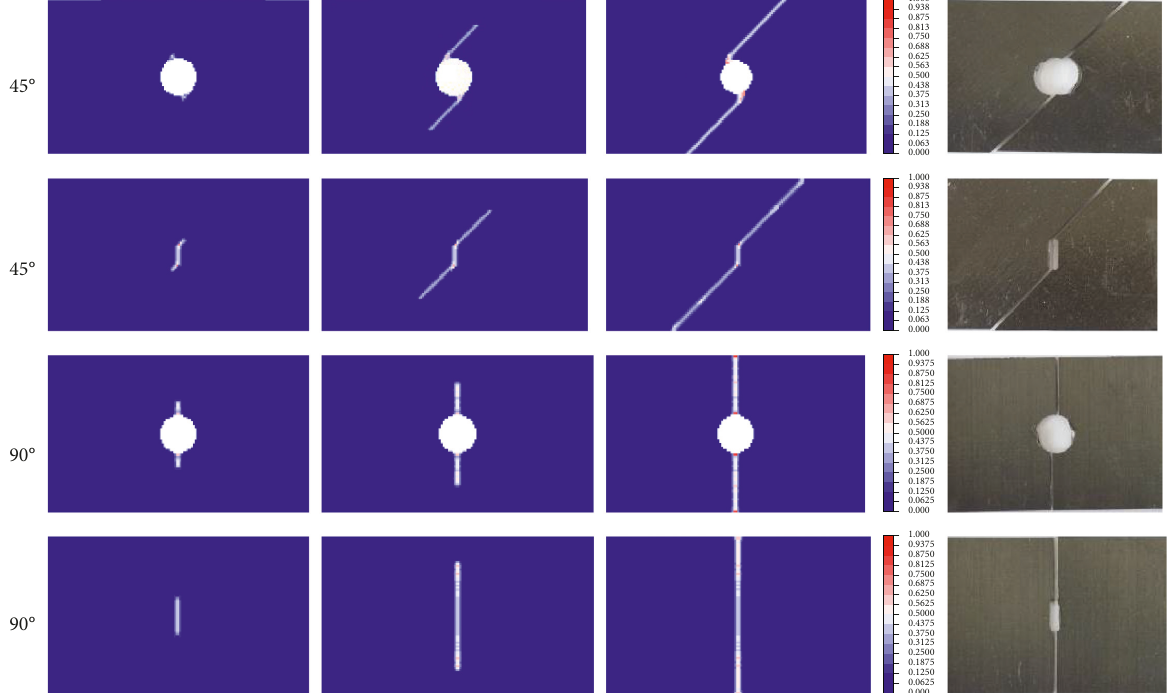
Figure 19: Progressive damage of lamina with fiber direction α